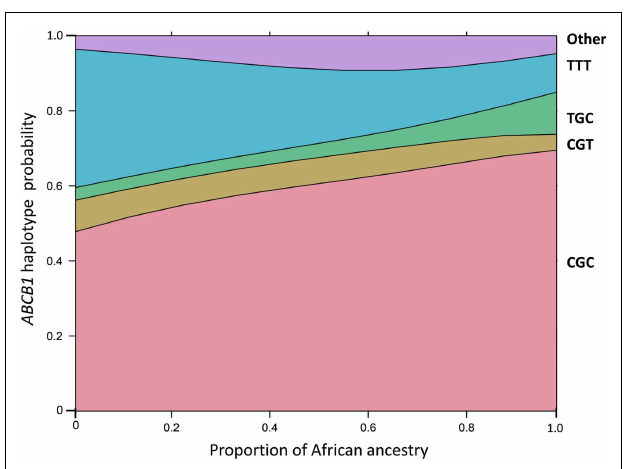
FIGURE 5 | Effect display for the distribution of ABCB1 haplotypes in the logit model fit to the data forAfrican ancestry in 965 Brazilians. The haplotypes comprising the 1236C > T, 2677G > nonG, and 3435C > T SNPs are shown at the right of the plot.The individual proportion of African ancestry is shown in the x -axis.The y -axis is labeled on the probability scale.The plot was generated as described byVenables and Ripley (2002) and implemented as function “multinom” available in the R package “nnet.” Data from Sortica et al.